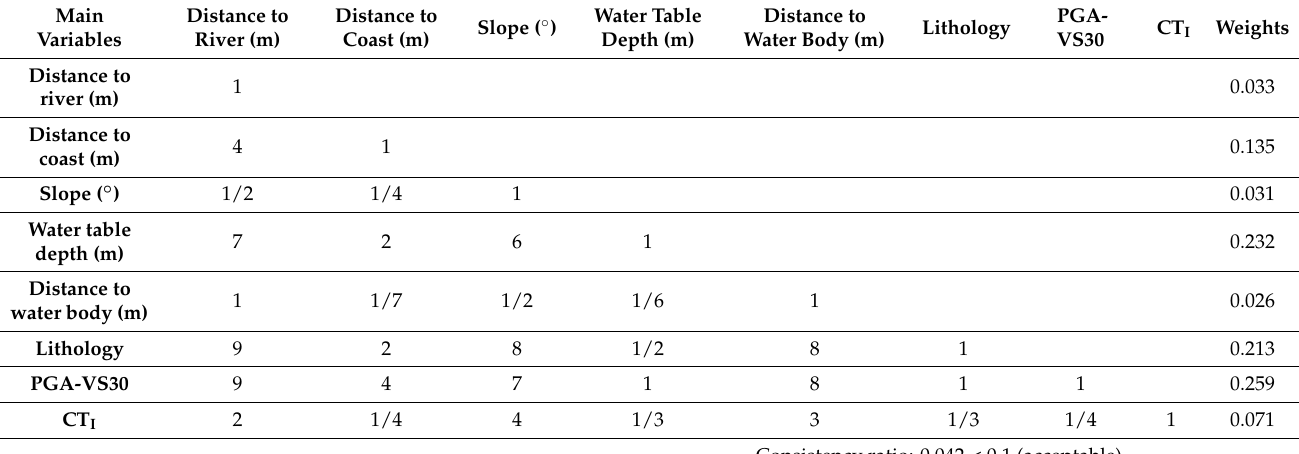
Table 2. Pairwise comparison matrix and normalized weights of the analyzed factors. The consistency ratio is also